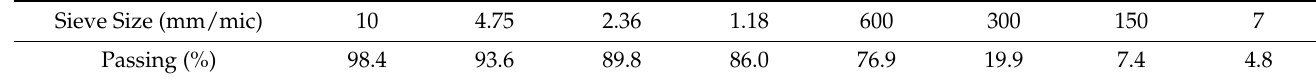
Table 3. Fine aggregate grading.